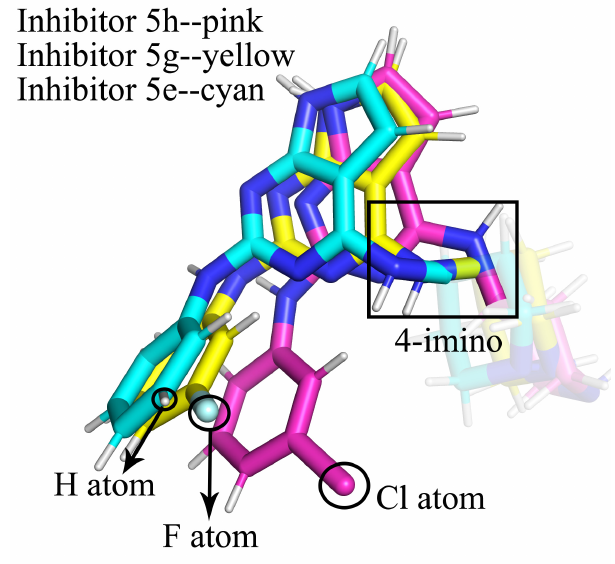
Figure 12. The positions of the halogen atoms on the 2-benzene rings in relation to the 4-imino groups in inhibitors 5h, 5g, and 5e.